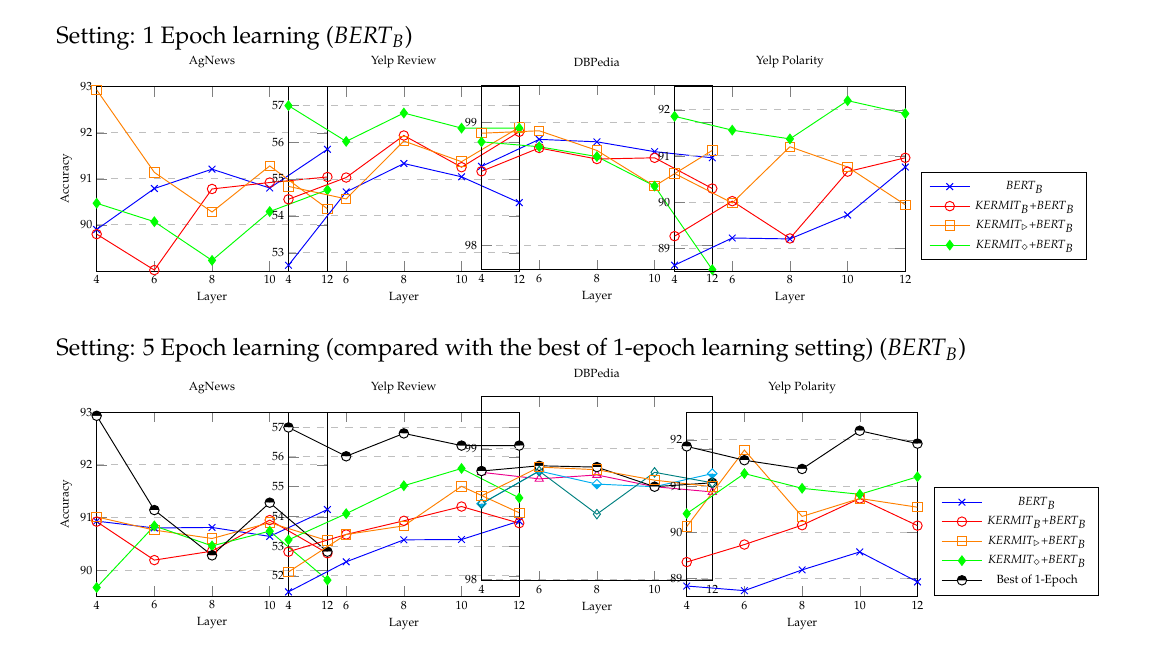
Figure 2. Comparison between KERMIT (cid:46)(cid:47) Transformers and BERT when training layers in BERT B : Accuracy vs. Learned Layers in two different learning configurations—1-Epoch and 5-Epoch training In fact, KERMIT (cid:46)(cid:47) Transformers outperforms a trained BERT B in both the 1-epoch and 5-epoch settings for any number of trained layers (see Figure